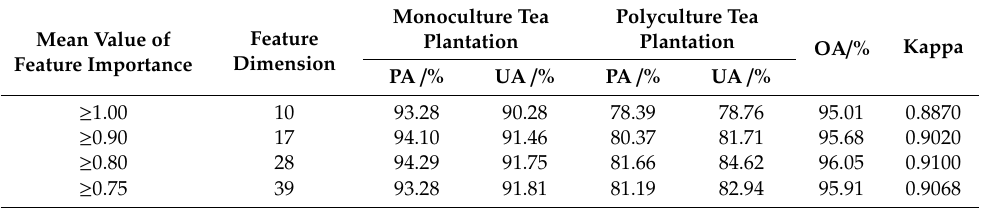
Table 4. Accuracy comparison of classification results with di ff erent numbers of optimum